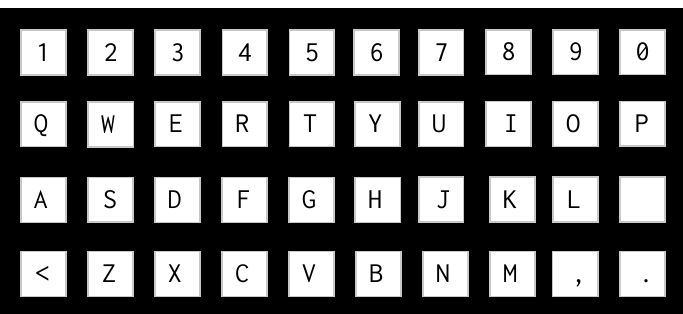
Figure 4. A 40–target stimulation interface.